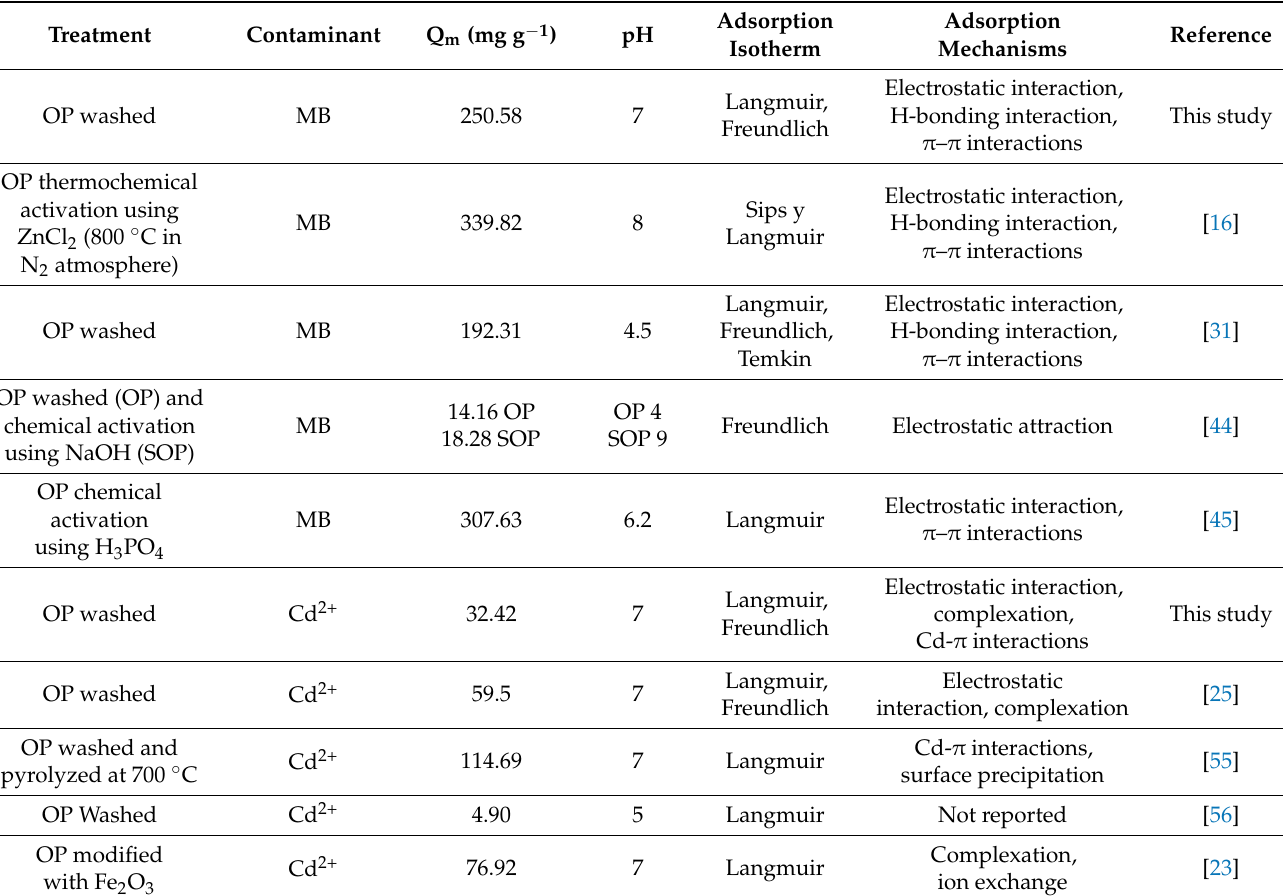
Figure 2. Langmuir and Freundlich isotherms for ( a ) MB and ( b ) Cd 2+ . Table 3. Comparison of maximum adsorption capacities for MB y Cd 2+ monocomponent ) were 0.7824 mmol g −1 (250.6 mg g −1 ) and The maximum adsorption capacities (Q (cid:2923)